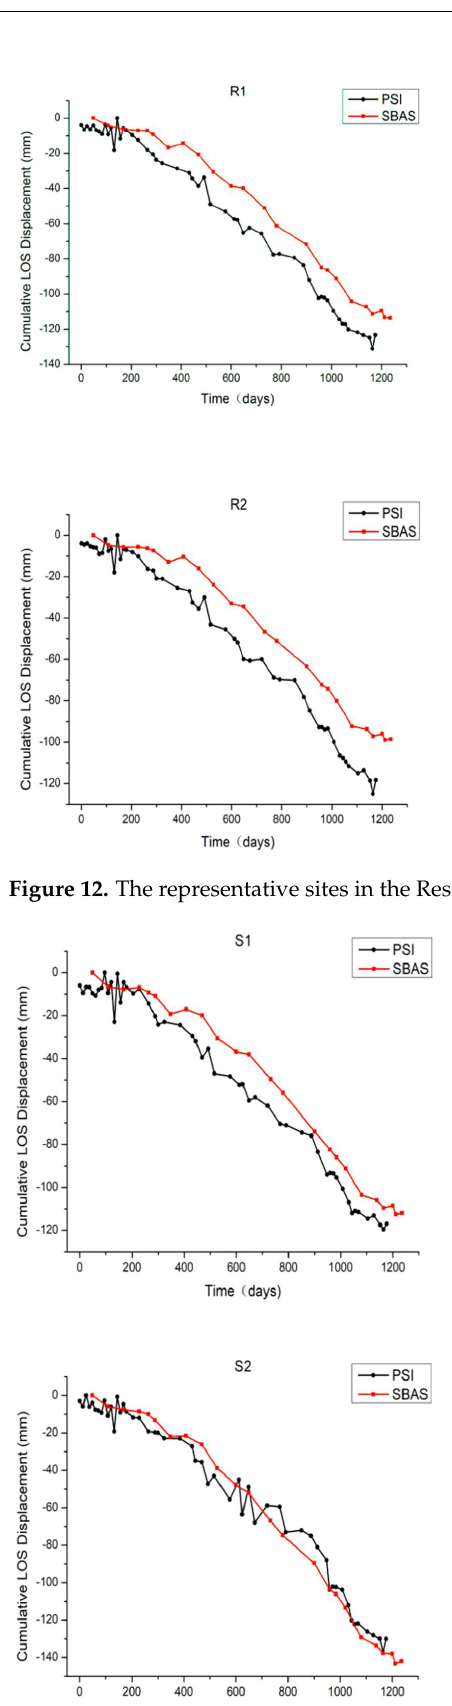
Figure 13. The representative sites in the sea view community zone.